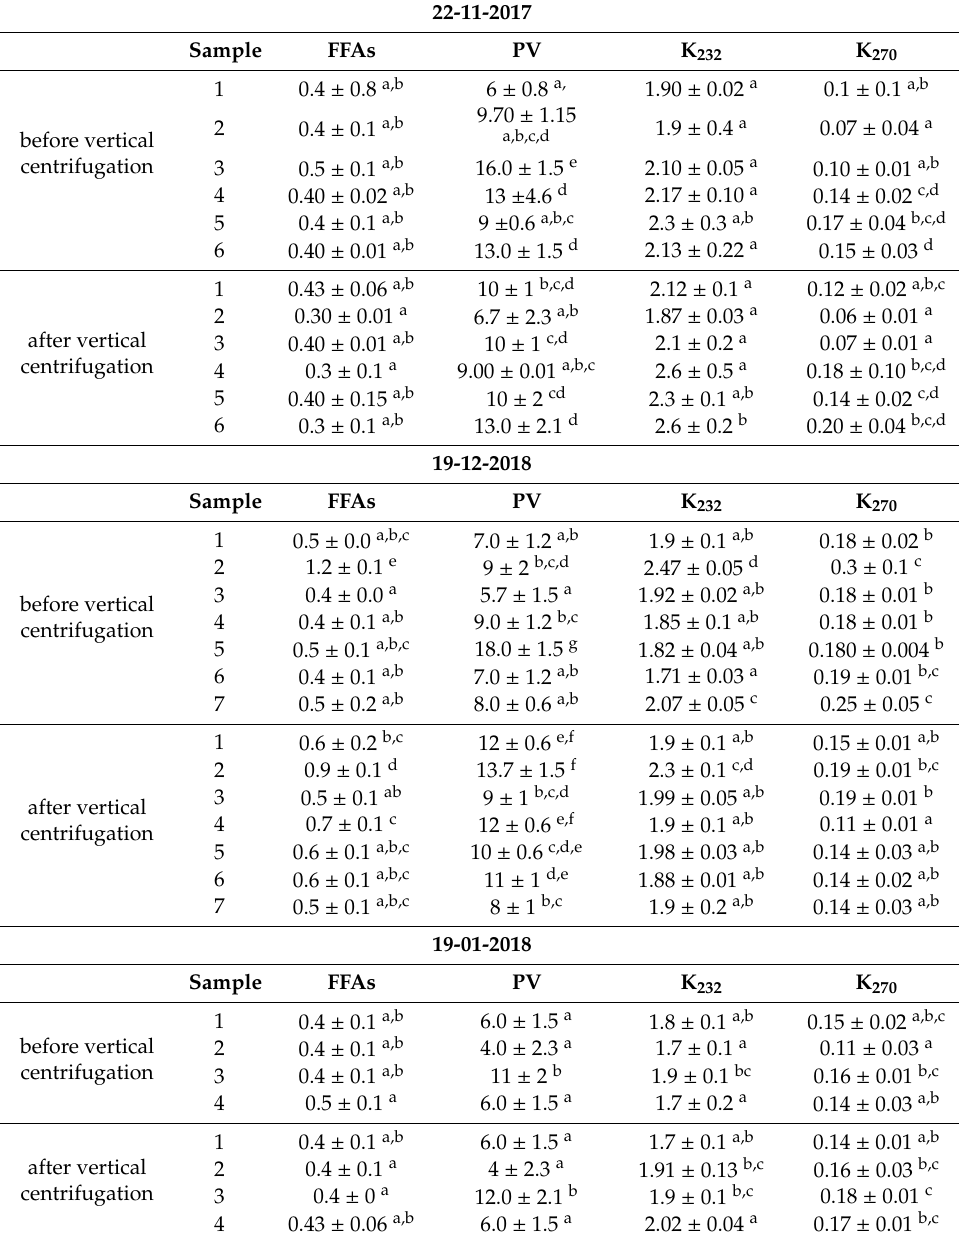
Table 1. Quality indices of olive oil